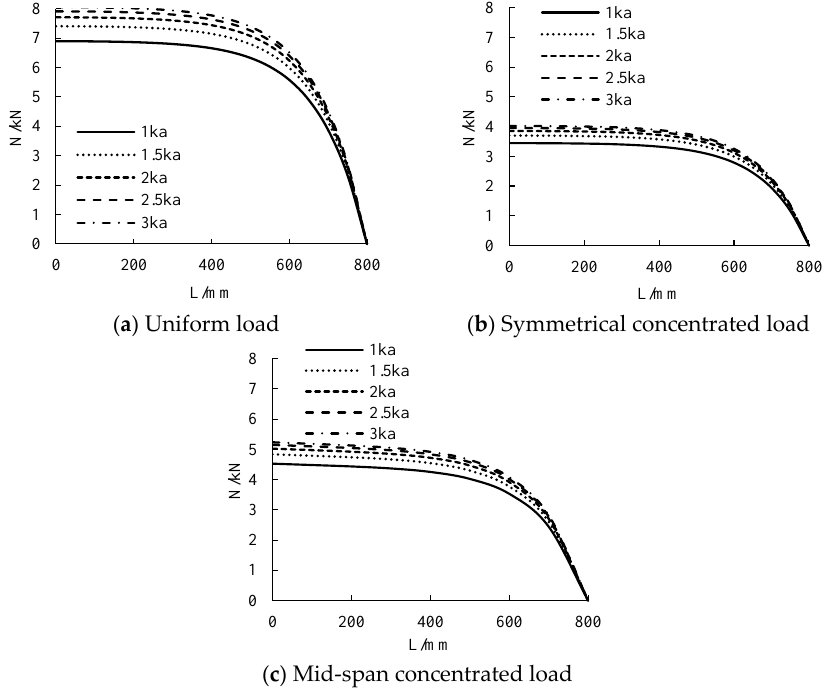
Figure 8. The influence of adhesive layer stiffness on tensile force.